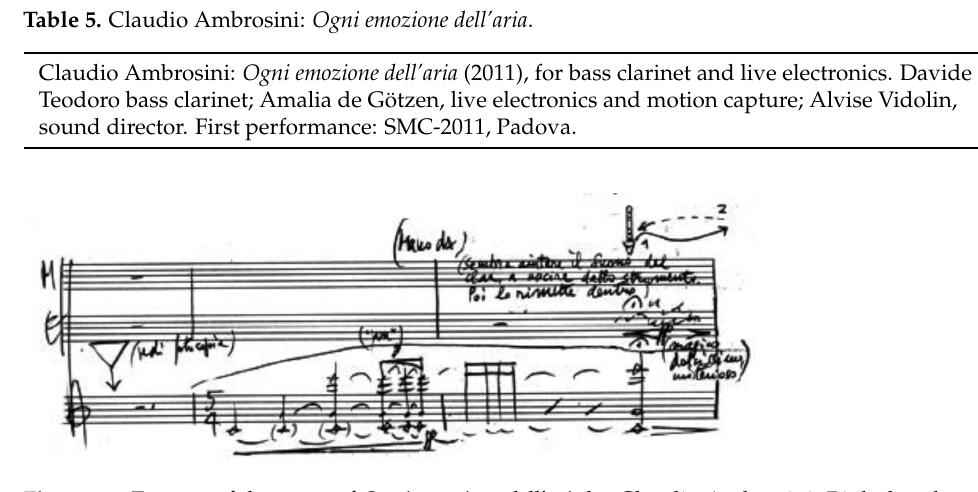
Figure 23. Excerpt of the score of Ogni emozione dell’aria by Claudio Ambrosini. Right hand move- ments are indicated in the top